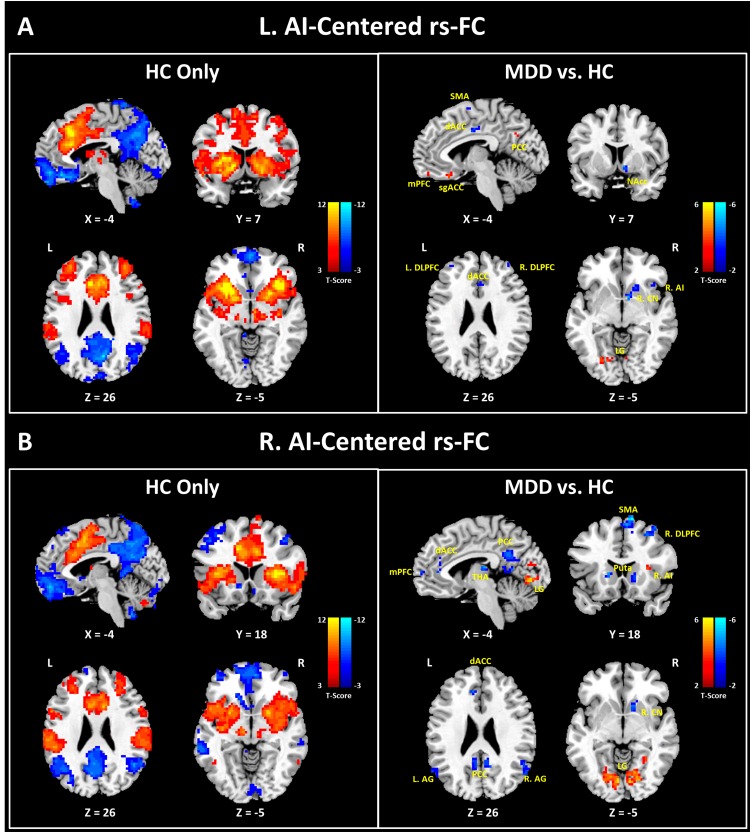
Results of resting-state functional connectivity analysis (rs-FC).Voxel-wise analyses were performed for each subject, followed by group-level t-tests. One-sample t-tests were only used for the HC data to show the intact rs-FC in the healthy state (left parts of A and B). Two-sample t-tests were used to show the altered rs-FC caused by MDD (right parts of A and B). (A) Results of L. AI-centered rs-FC analysis. (B) Results of R. AI-centered rs-FC analysis. The color bars indicate t-values for each analysis. Abbreviation: mPFC, medial prefrontal cortex; sgACC, subgenual part of anterior cingulate cortex; dACC, dorsal part of anterior cingulate cortex; SMA, supplementary motor area; PCC, posterior cingulate cortex; NAcc, nucleus accumbens; LG, lingual gyrus; DLPFC, dorsolateral prefrontal cortex; CN, caudate nucleus; AI, anterior insula; THA, thalamus; Puta, putamen; AG, angular gyrus; L, left; R, right.